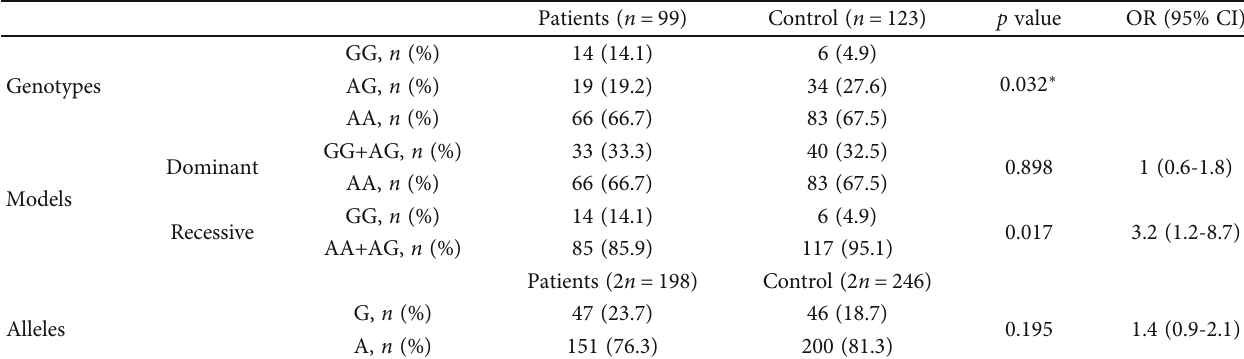
Table 2: Genotype and allele frequency of AIRE rs760426 in the lupus patients and control